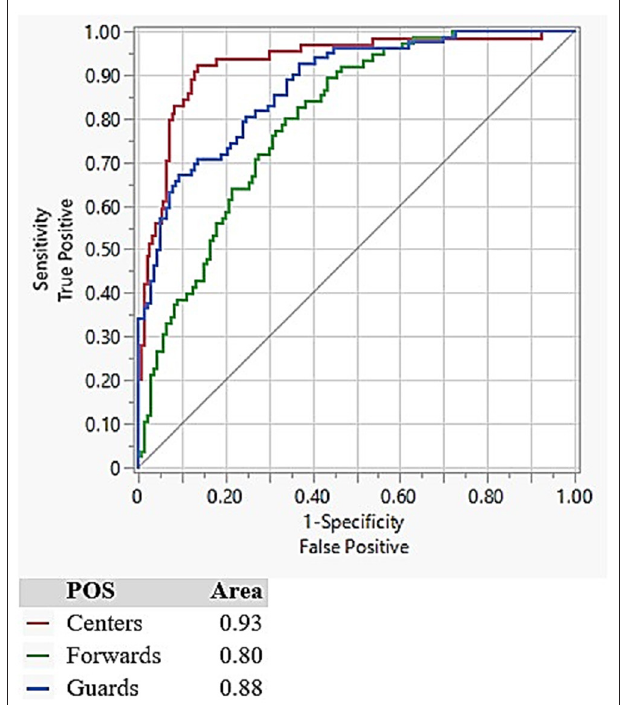
FIGURE 3 | Receiver operating characteristic curves for each of the athlete position groups.